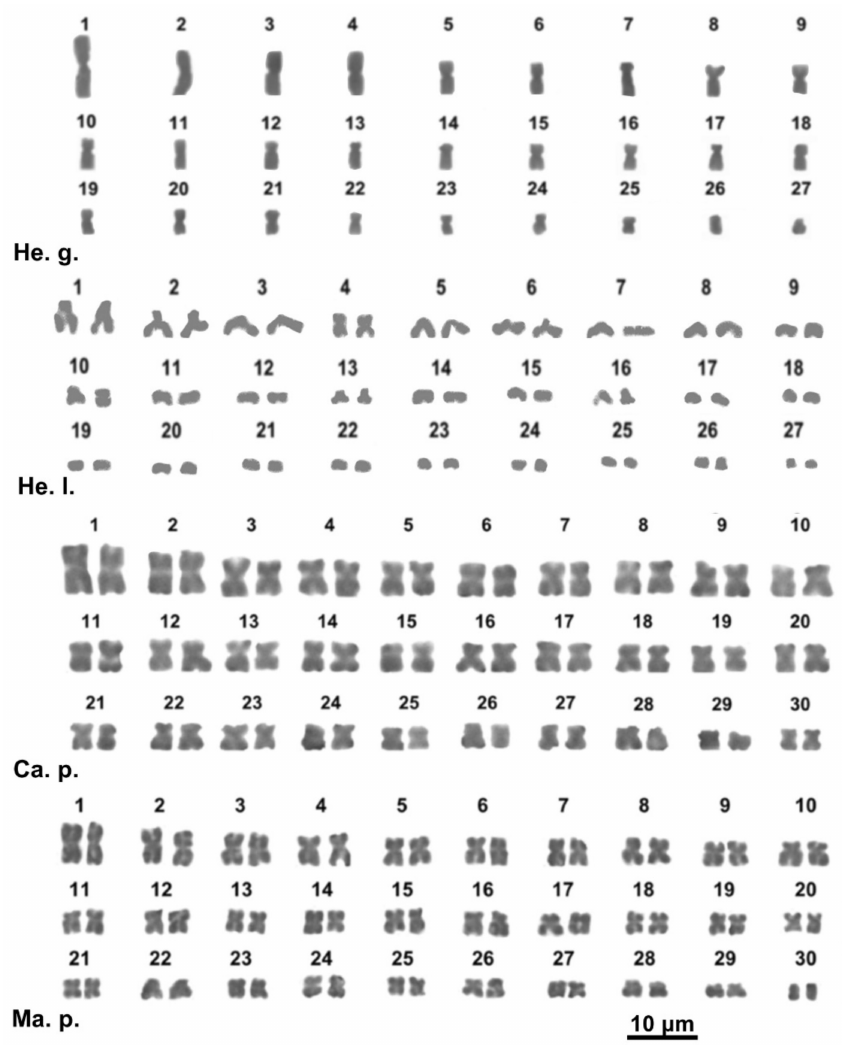
Figure 3. Giemsa-stained karyotypes of Helix gussoneana (He. g.), H. lucorum . (He. l.), Campylaea planospira (Ca. p.), Marmorana platychela (Ma.